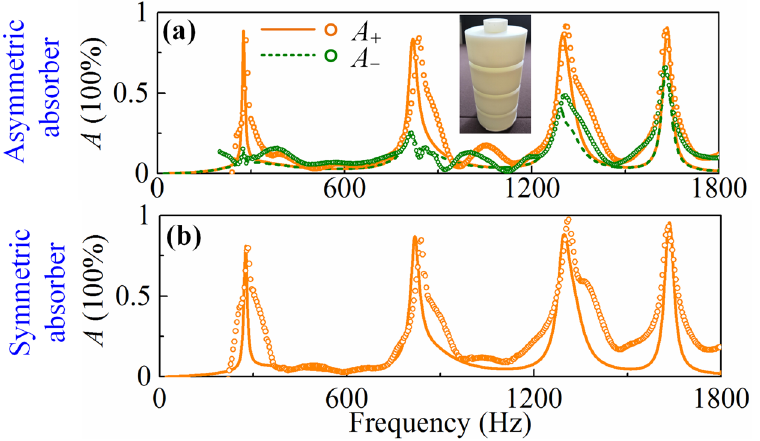
Figure 5. Multi-band absorptances of the (a) asymmetric and (b) symmetric system using MHR block with N = 4.